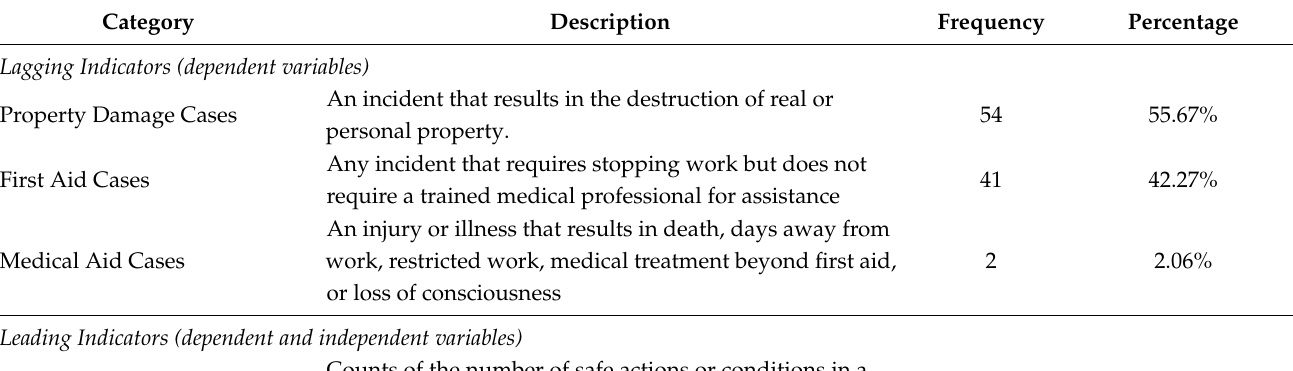
Table 1. Variables available for model